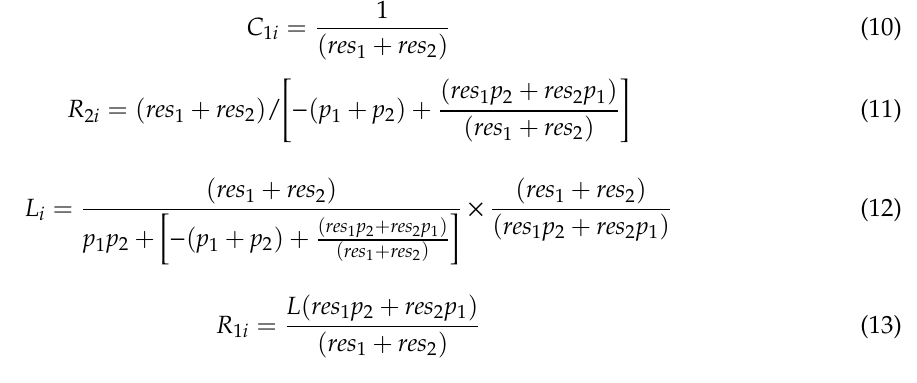
Figure 5. Equivalent circuit associated with complex conjugate pairs. The circuit parameters associated with Figure 5 and Equation (9)—i.e., C 1 i , R 2 i , L i , and R 1 i —can be calculated from the poles ( p 1 and p 2 ) and residues ( res 1 and res 2 ) of the complex conjugate pairs using Equation (10) to (13),